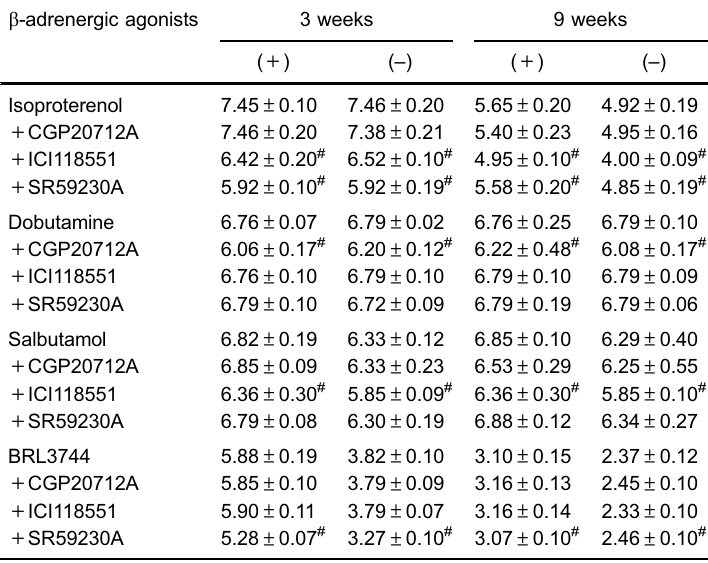
Table 3. Relaxation induced by b -adrenergic agonists and speci fi c antagonists on aortic rings with ( + ) or without ( – ) endothelium from 3- and 9-week-old rats. b -adrenergic agonists